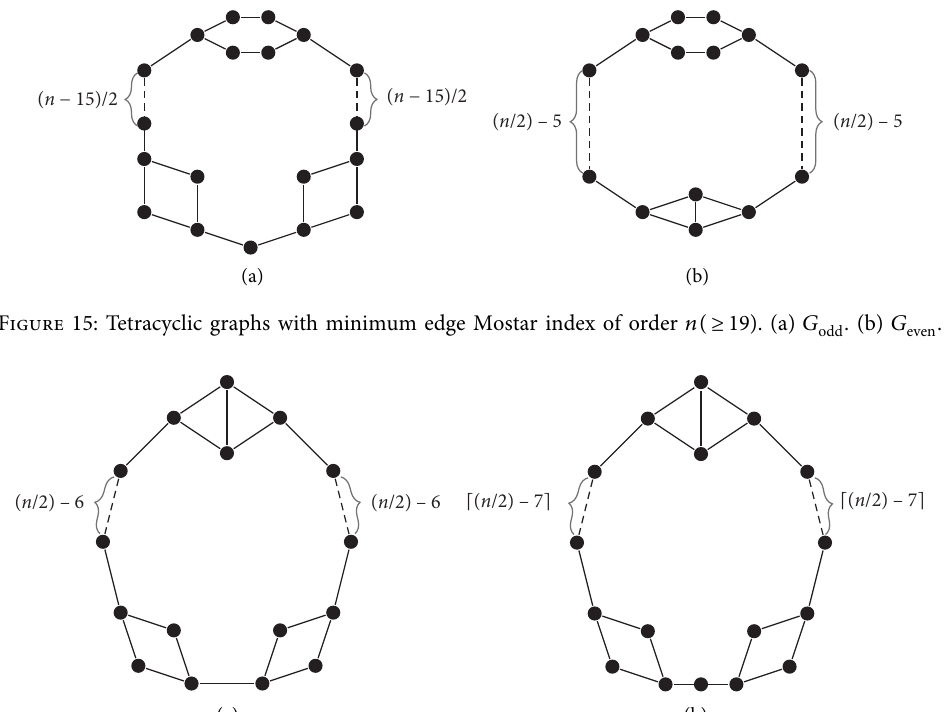
Figure 16: Pentacyclic graphs with minimum edge Mostar index of oder n ( ≥ 14 ) . (a) G